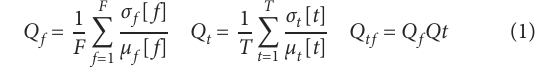
problem. The second type was based on the Law’s mask filters